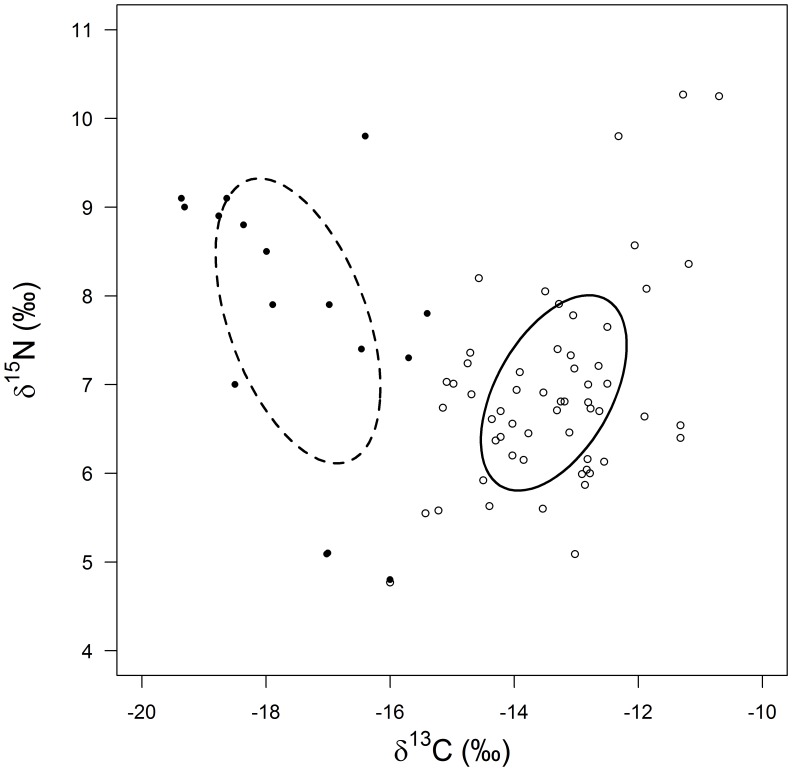
Stable isotope bi-plot of individual Procambarus clarkii collected at Lake Naivasha during 2002.The sub-population collected from hippo footprints onshore are represented by solid symbols, and those from within the lake by open symbols. The corrected standard ellipse area (SEAc) is plotted for each sub-population.